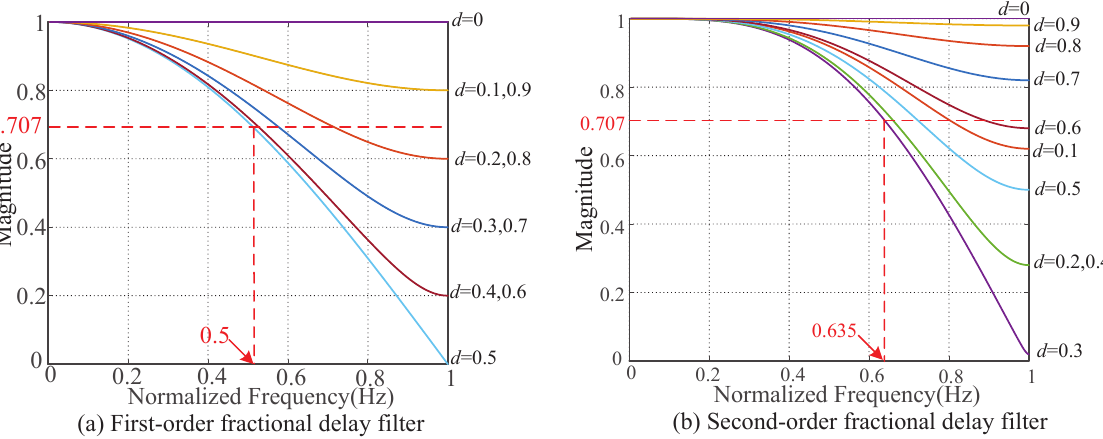
Figure 3. Amplitude response of first-order and second-order FD filters based on Taylor series